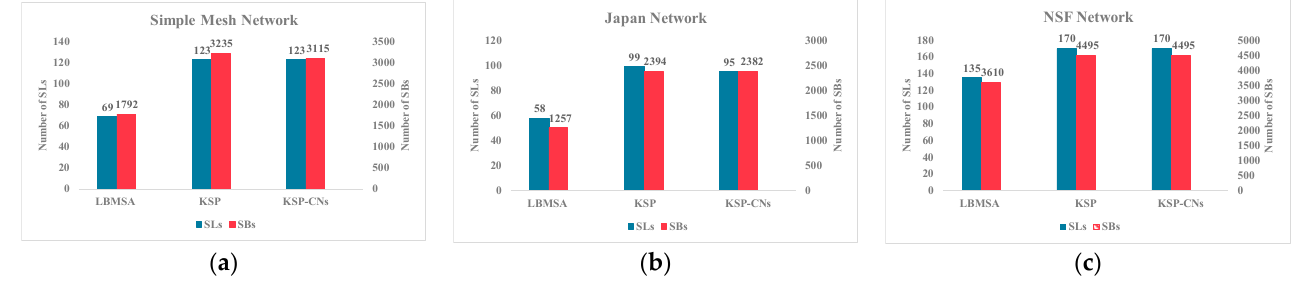
Figure 5. ( a ) The number of occupied SLs and SBs for the LBMSA algorithm, the KSP algorithm, and the KSP-CNs algorithm in the simple mesh network; ( b ) The number of occupied SLs and SBs for the LBMSA algorithm, the KSP algorithm, and the KSP-CNs algorithm in the Japan network; ( c ) The number of occupied SLs and SBs for the LBMSA algorithm, the KSP algorithm, and the KSP-CNs algorithm in the NSF network.